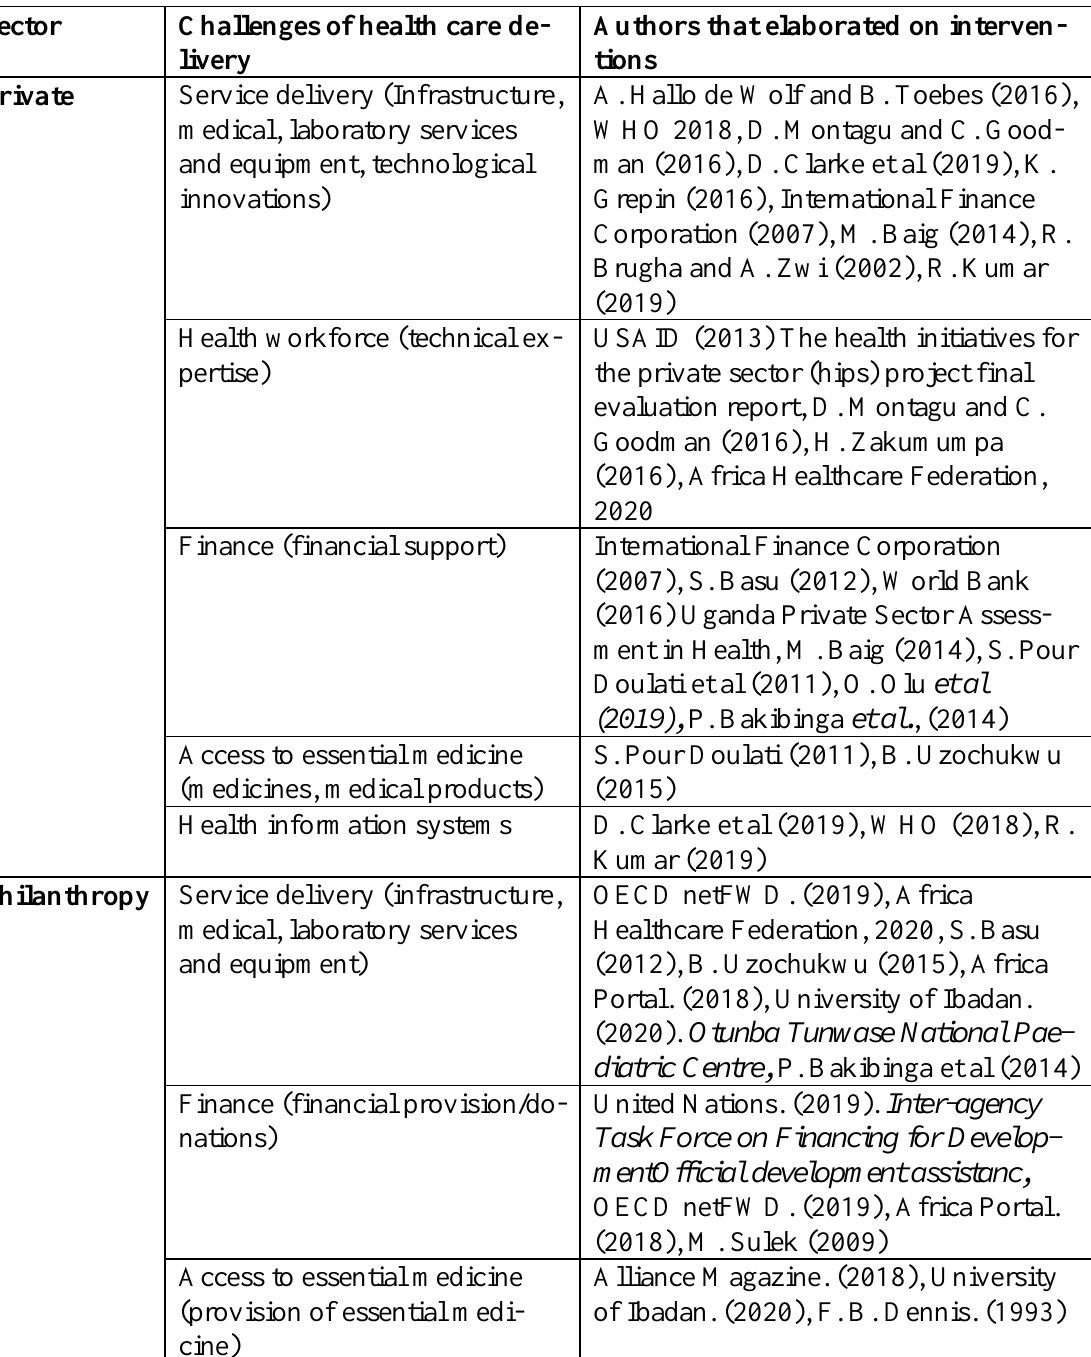
Table 2: Summary of papers